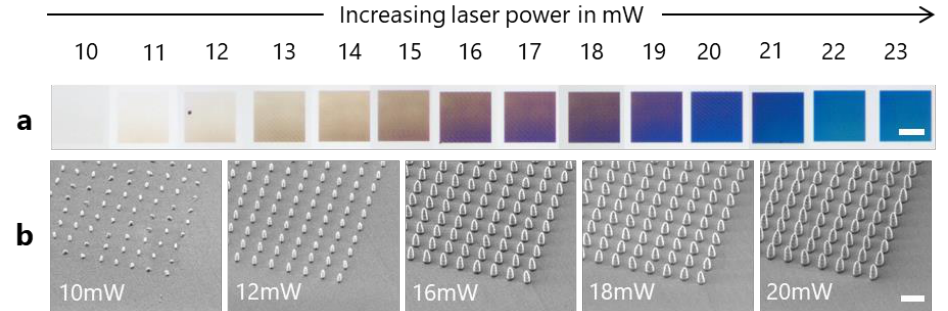
Figure 2. Optical appearance of the nanopillar gratings in dependence on the laser power. ( a ) Optical micrographs of 50 × 50 µm nanopillar gratings on a fused silica substrate. Scale bar is 25 µm. ( b ) Scanning electron micrographs showing the corresponding nanopillars. Scale bar is 1 µm. Nanomaterials 2019 , 9 , x FOR PEER REVIEW